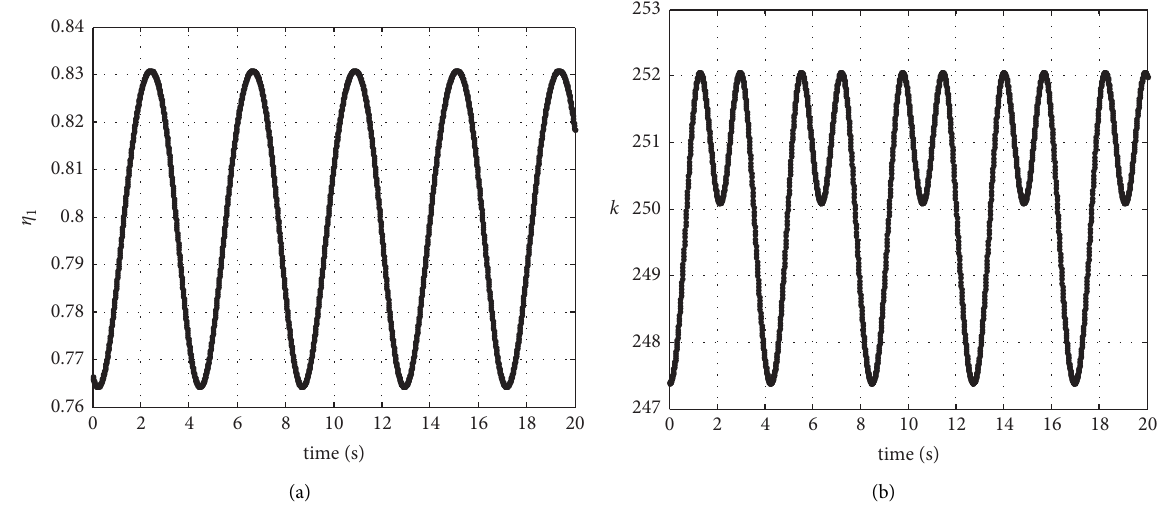
Figure 8: Multiobjective functions with time. (a) Transmission index. (b) Condition